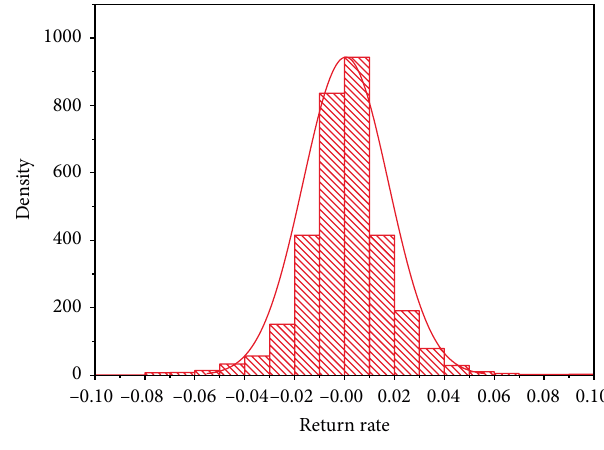
Figure 2: Return rate histogram of real